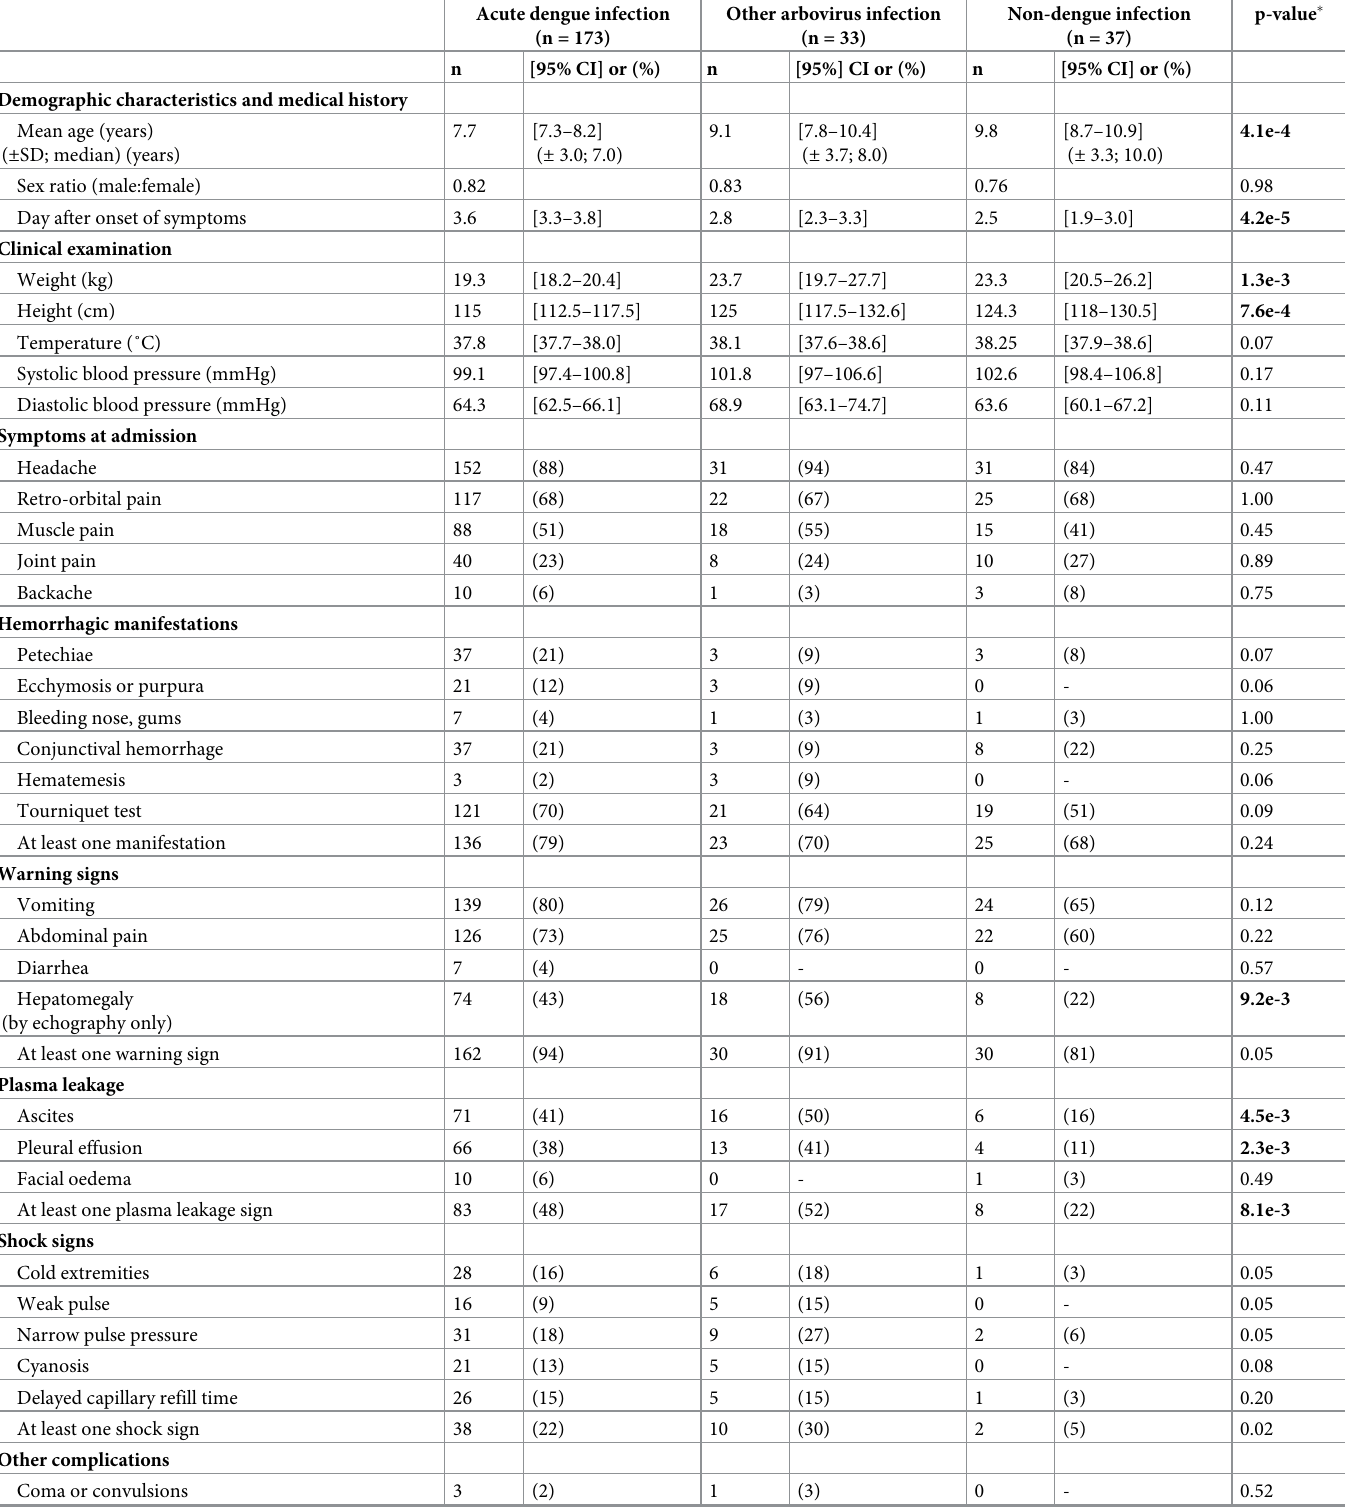
Table 1. Demographic, clinical and biological characteristics of included patients at hospital admission (n =